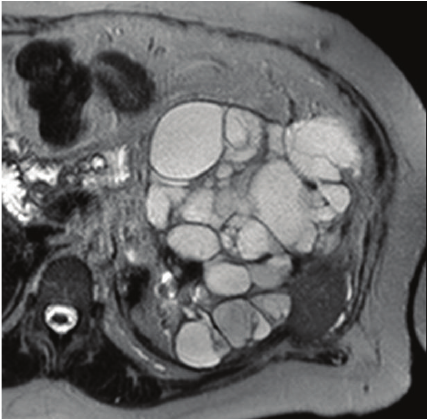
Figure 5: T2 weighted MRI 5 years 1 month after ablation shows total disappearance of solid